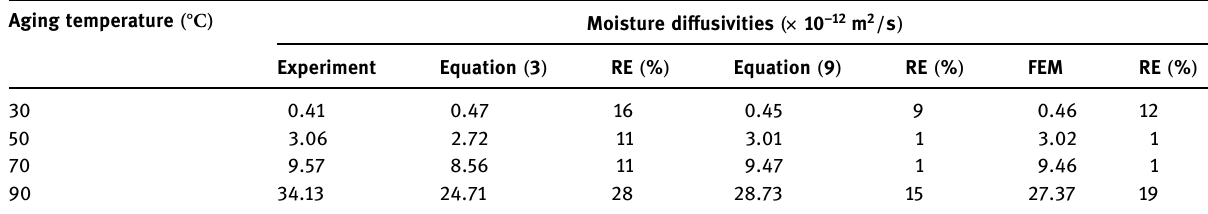
Table 1: Comparison of water di ff usivities obtained by experimental data, the classical Halpin – Tsai equation ( equation ( 3 )) , and the modi fi ed Halpin – Tsai equation ( equation ( 9 )) in the CF/PA6 ( Panex ® 35 - 50K ) composites. Here RE ( % ) denotes the relative error Aging temperature ( ℃ )